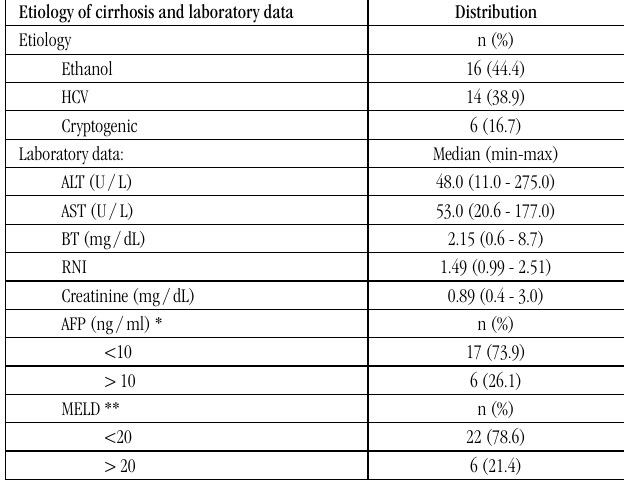
TABLE 2 - Distribution of Etiology of cirrhosis and laboratory data on patients undergoing liver transplantation at HC-UFMG between 2003 and 2015 Etiology of cirrhosis and laboratory